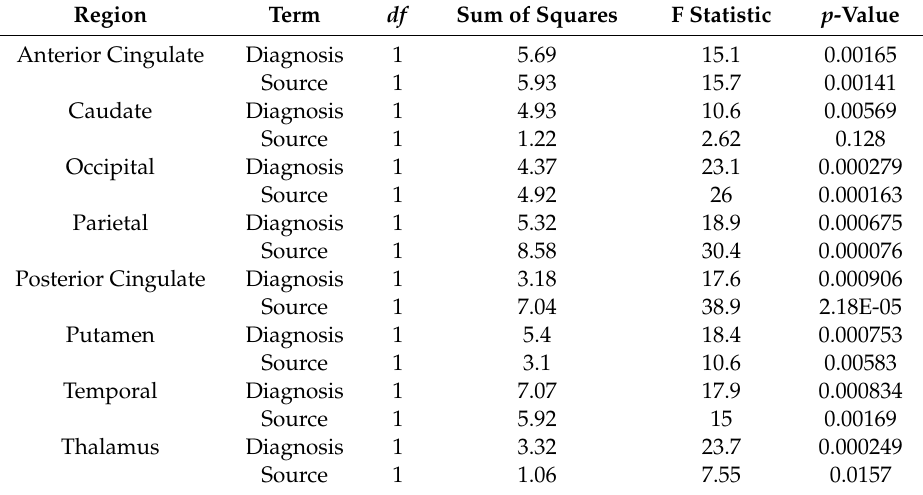
Figure 4. Dot plot of estimated binding potential (BP) [32] images by positron emission tomography after intravenous bolus injections of 185 MBqs (5 mCis) of [ 18 F]FPEB [25,30] for men with fragile X syndrome ( N = 9) and age-matched men with typical development ( N = 8) from the IND and JHU [52,55,79]. Table 2. Analysis of variance of estimates of mGluR 5 expression by positron emission tomography after intravenous bolus injections of 185 MBqs (5 mCis) of [ 18 F]FPEB in cortical and subcortical regions in the combined sample of men with fragile X syndrome ( N = 9) and age-matched men with typical development ( N = 8).